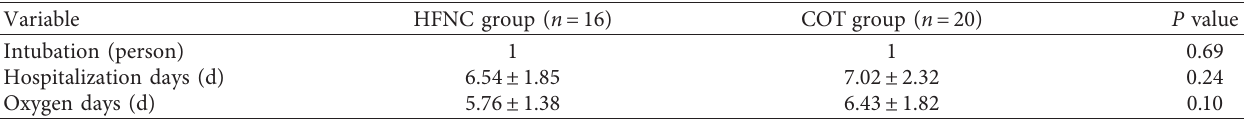
Figure 2: Respiratory rate and heart rate of patients follow a downward trend with time. The statistical data indicated no significant differences between the two treatments at 0, 2, and 8 h but heart rate and respiratory rate were lower in the HFNC group compared with the COT group from 24h to 48h ( ∗ P < 0 . 05). Table 4: Medical indicators in the HFNC and COT